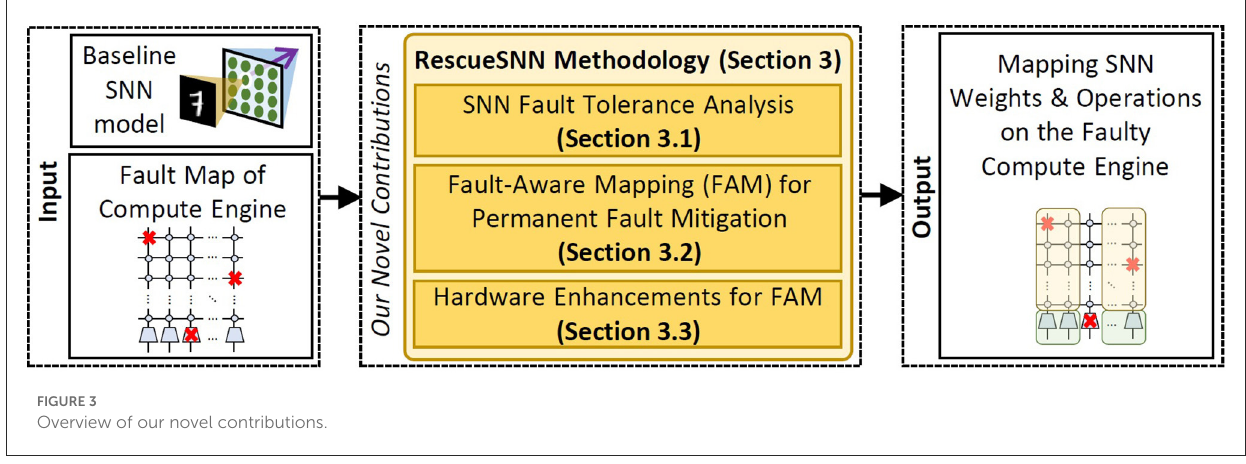
FIGURE3 Overview of our novel